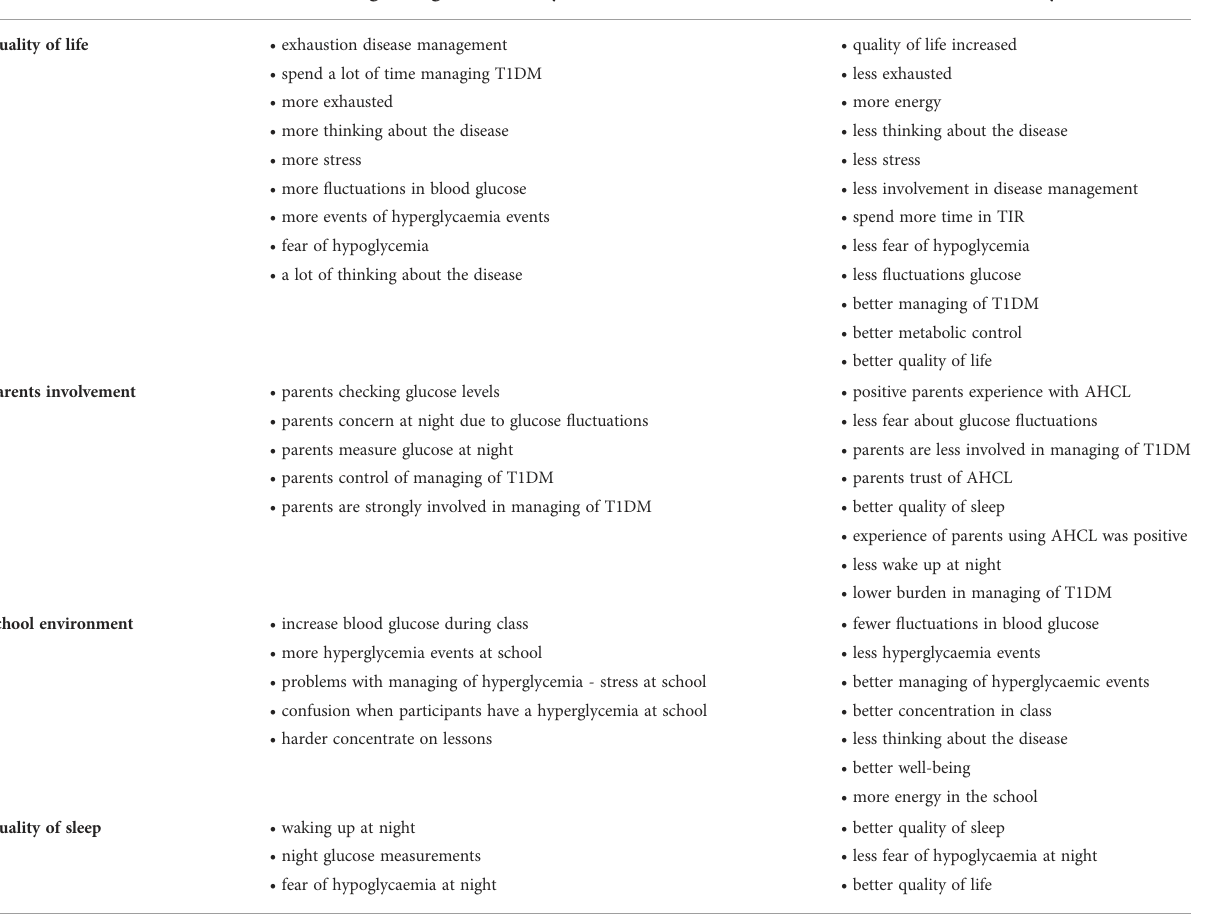
TABLE 6 Results: Focus groups interviews.